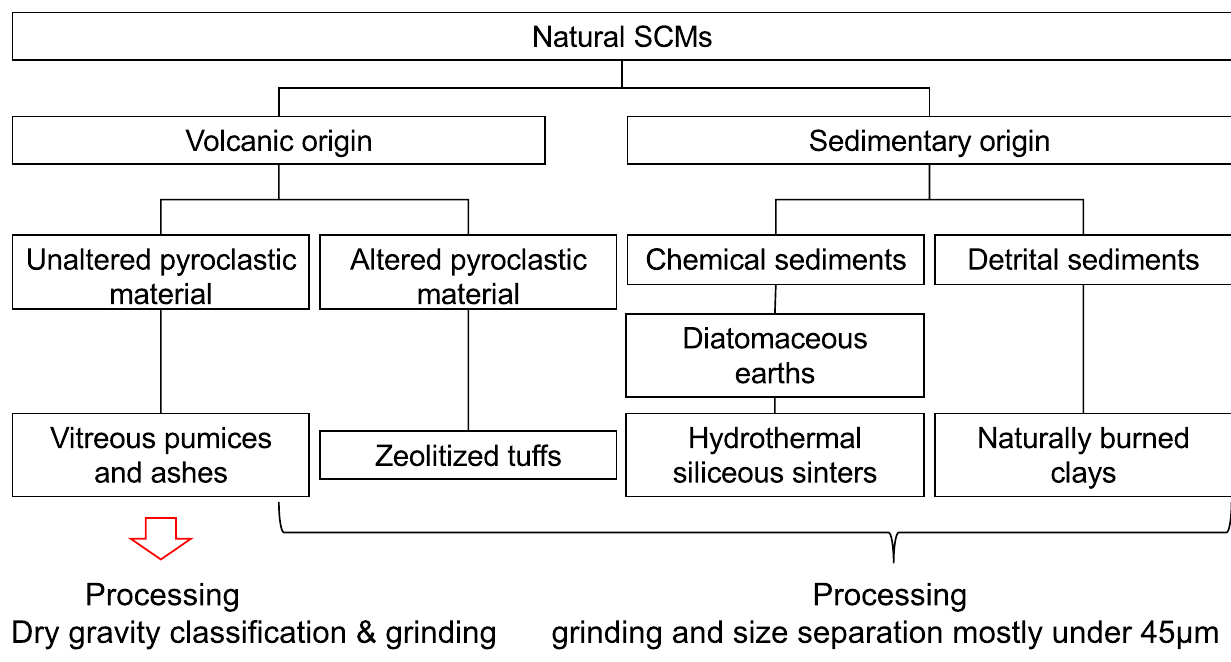
Fig. 1 General classification scheme of natural supplementary materials. Processing usually involves crushing grinding, and size separation, mostly under 45 μm. Modified after